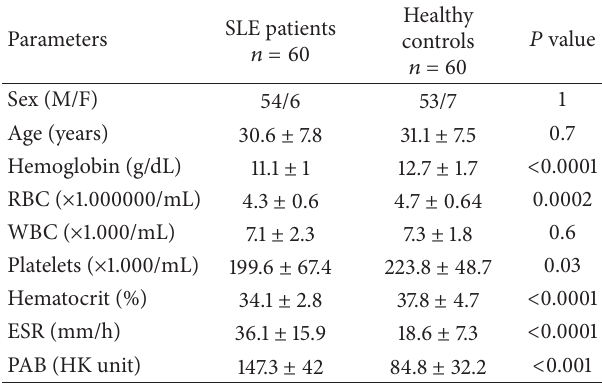
Table1:DemographicandlaboratorycharacteristicsofSLEpatients and healthy controls.